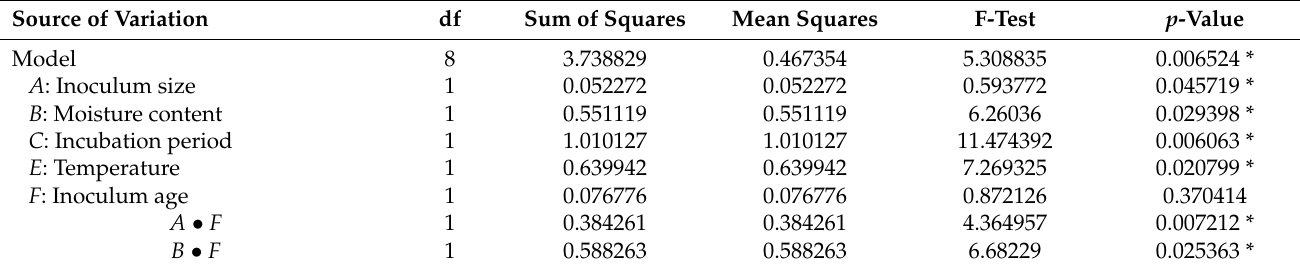
Table 7. ANOVA statistical data of FFD for screening critical growth factors of T. asperellum AU131. Source of Variation df Sum of Squares Mean Squares F-Test p -Value